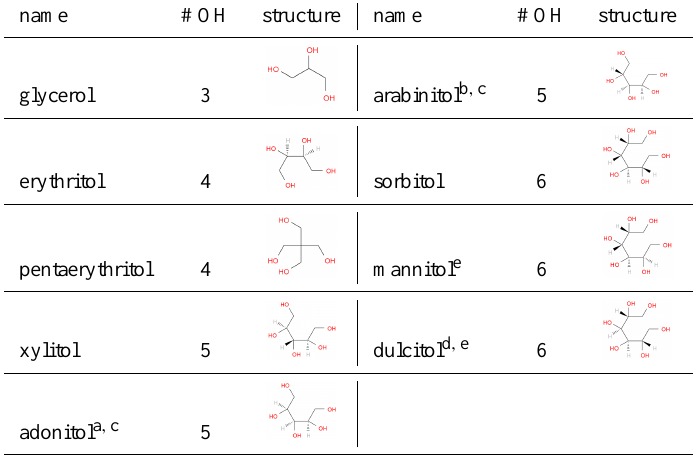
Table 1. Molecular structures of polyols with three or more hydroxyl groups, discussed in this work using non-IUPAC names.